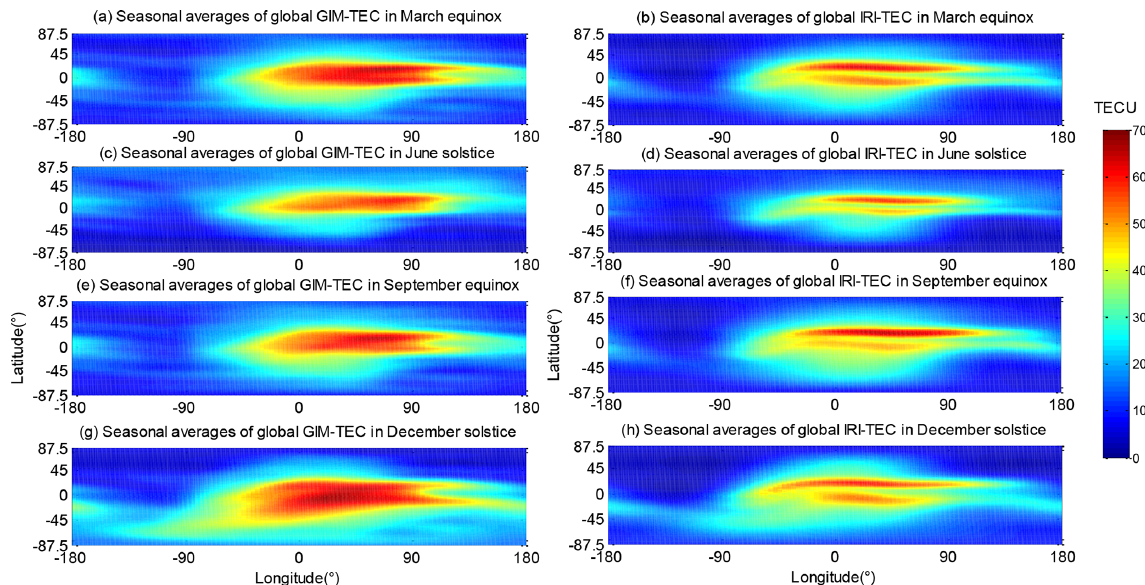
Figure 1. Season averages of global TEC obtained from GIM and IRI at 12:00UT in 2013. (a) GIM-TEC in the March equinox; (b) IRI- TEC in the March equinox; (c) GIM-TEC in the June solstice; (d) IRI-TEC in the June solstice; (e) GIM-TEC in the September equinox; (f) IRI-TEC in the September equinox; (g) GIM-TEC in the December solstice; and (h) IRI-TEC in the December solstice.